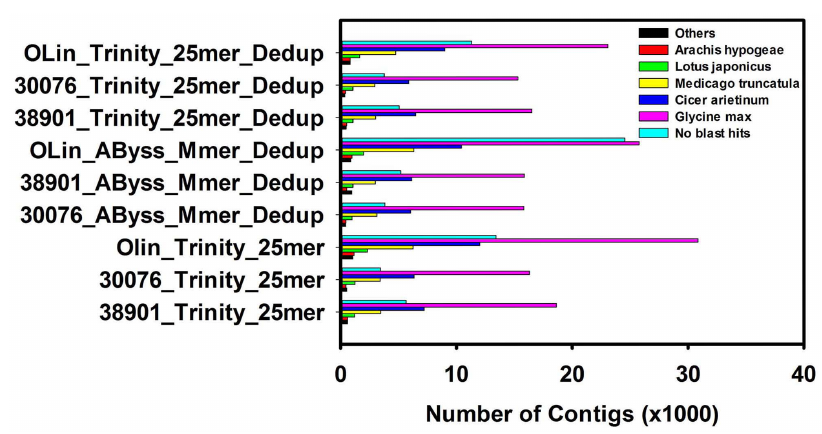
Fig. 5. Distribution of BLASTX hits by species for the single kmer and non-redundant assemblies of Trinity and TransAByss.